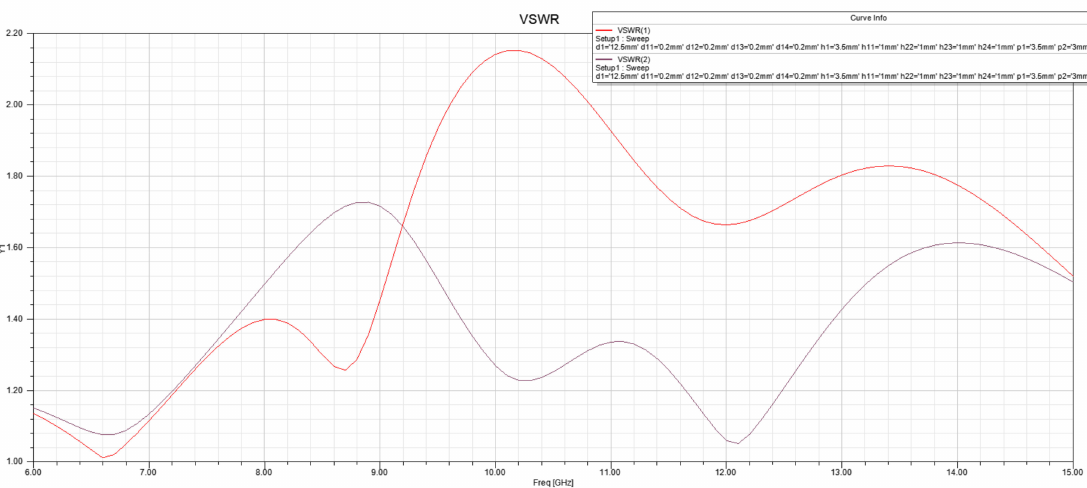
Figure 18. Input and output VSWR of the designed equalizer.